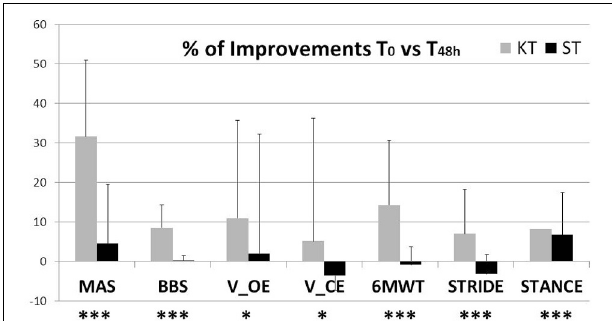
FIGURE 4 | Percentage of improvement due to 48-h application of KT or ST. ∗ p < 0 . 05, ∗∗∗ p < 0 .